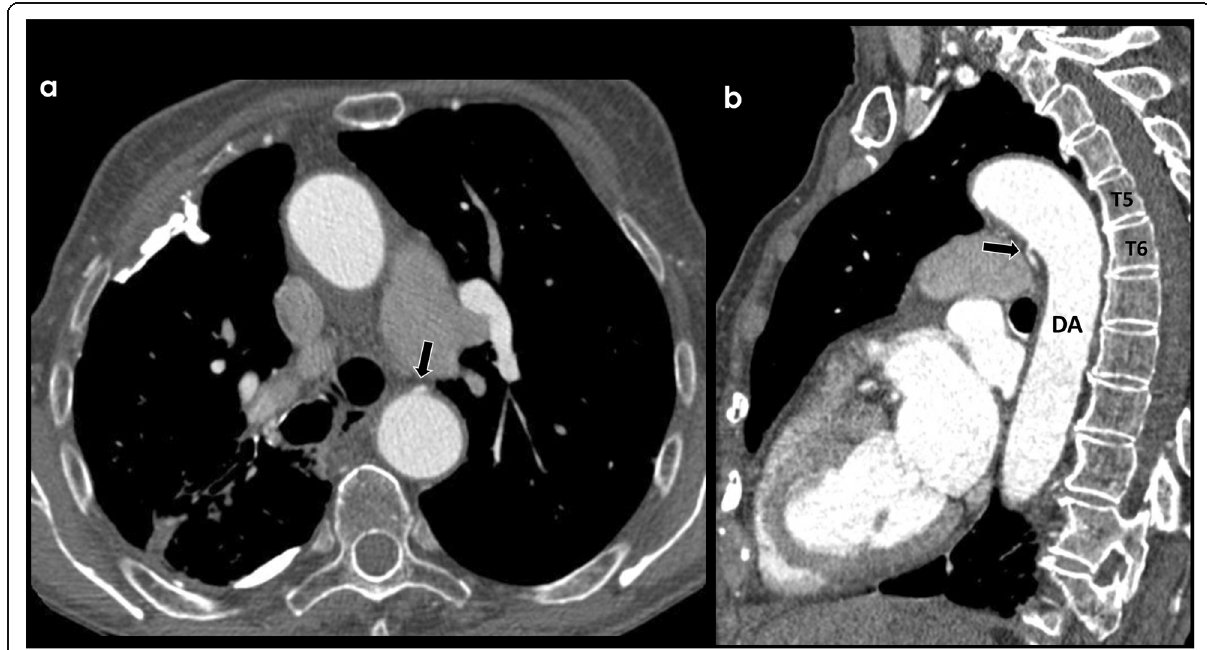
Fig. 1 Origin of orthotopic bronchial arteries. Axial ( a ) and sagital ( b ) CECT view of an orthotopic bronchial artery (black arrows) originating from the descending thoracic aorta (DA) at the T5 – T6 vertebral plane, near the carinal